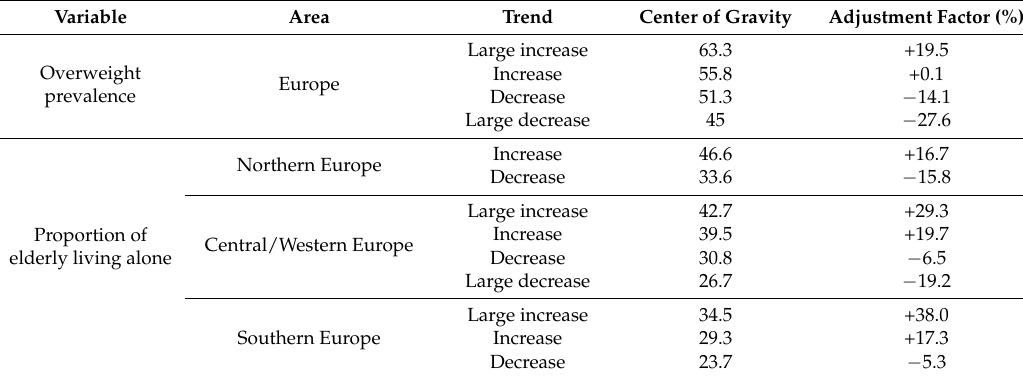
Table 6. Scenario-specific adjustments factors, i.e., percentage of increase or decrease for the period 2015–2050, for overweight prevalence at the European level and for the proportion of elderly living alone at the Sub-European